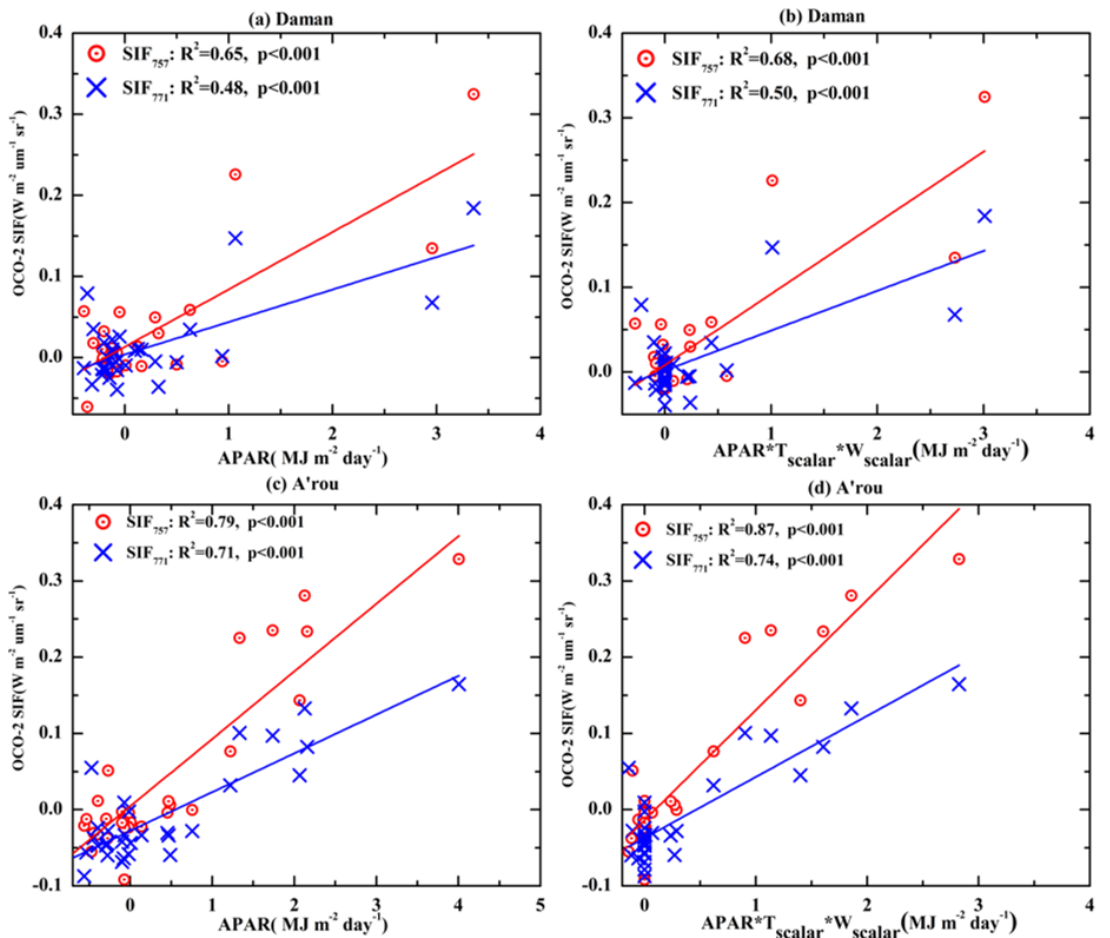
Figure 9. Relationships of the OCO-2 SIF with APAR and the product of APAR with two environmental scalars (APAR × T scalar × W scalar ) at a daily timescale: ( a ) OCO-2 SIF versus APAR at the Daman site; ( b ) OCO-2 SIF versus APAR with two environmental scalars at the Daman site; ( c ) OCO-2 SIF versus APAR at the A’rou site; ( d ) OCO-2 SIF versus APAR with two environmental scalars at the A’rou site.